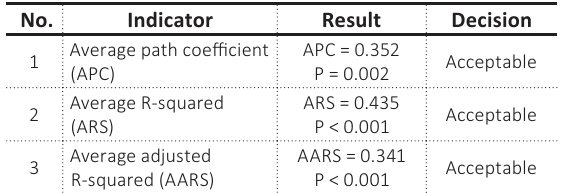
Table 2. Model test